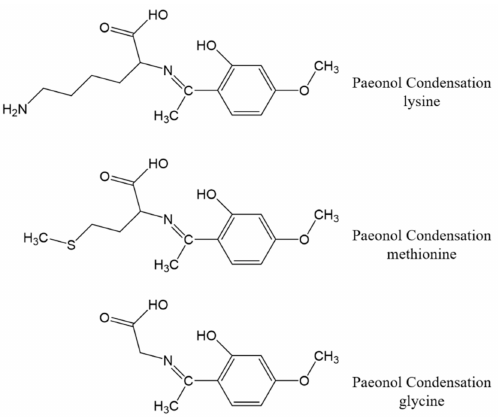
Figure 1. Molecular structures of Schiff base: PCLys, PCGly, and